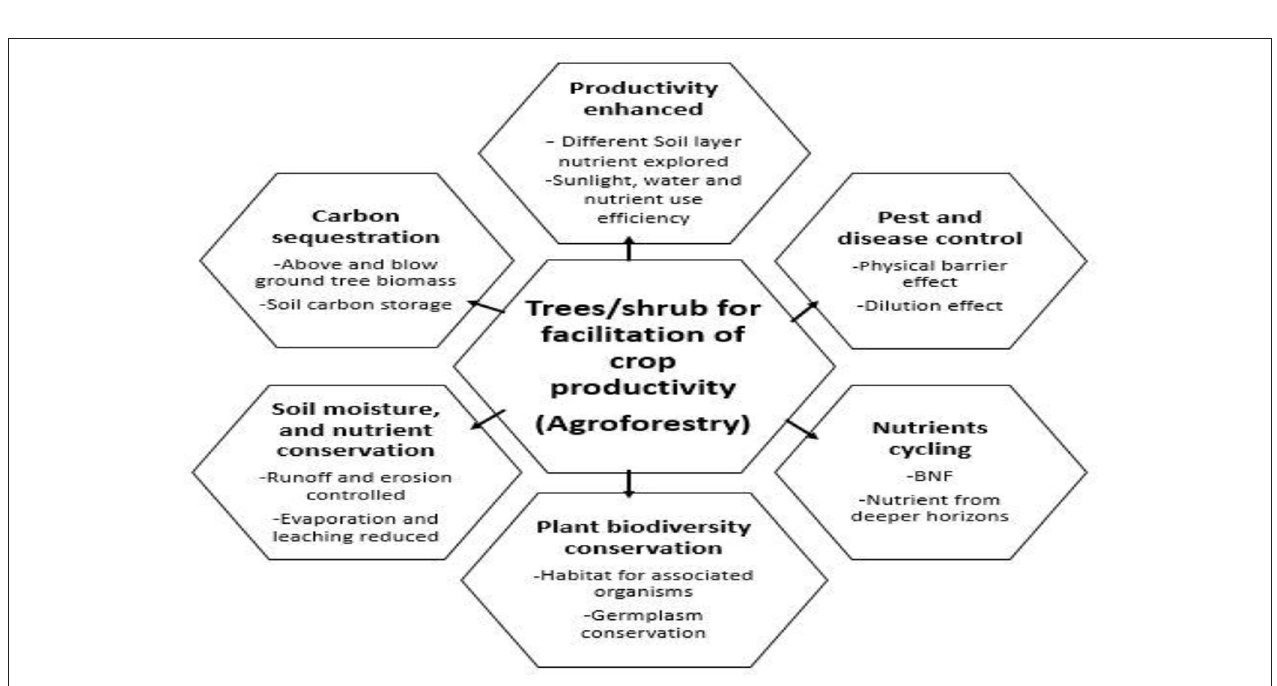
poverty and improve farmers’ livelihoods (Dzanku et al.,